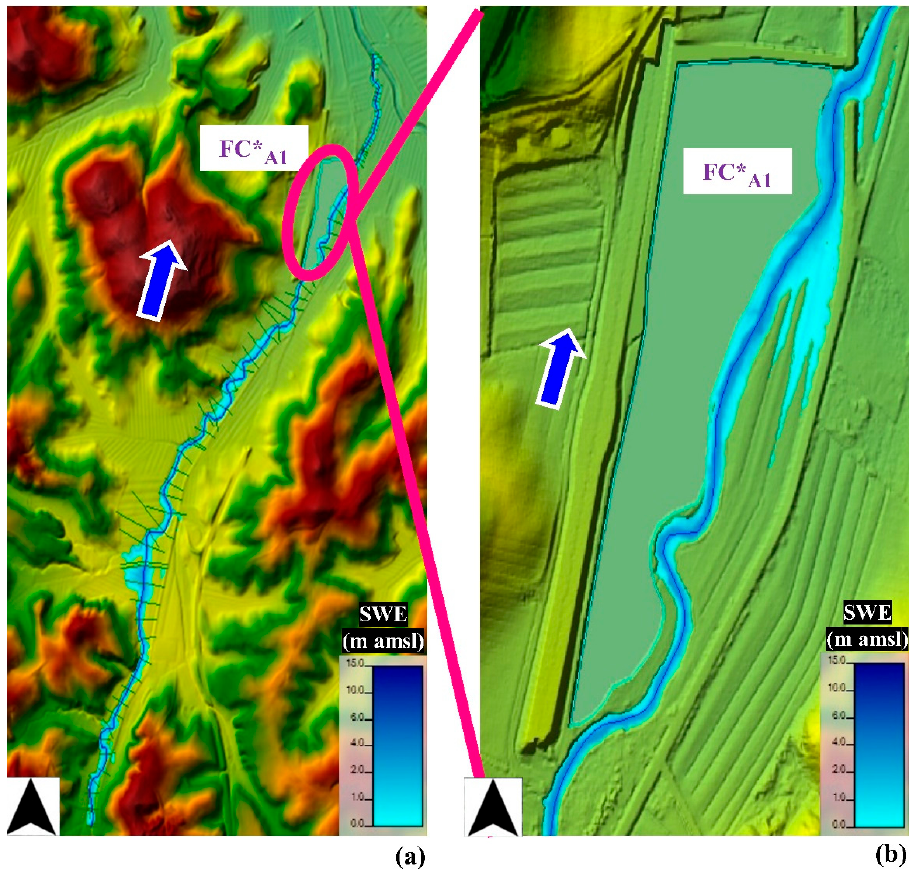
Figure 11. ( a ) Surface water elevations SWE (m a.m.s.l.) outcoming from the 2D unsteady simulation for Morra Creek, obtained by considering the only vegetated flood control area FC* A1 . ( b ) Detailed view of FC* A1 area model, and corresponding SWE (m a.m.s.l.). The blue arrow indicates the flow